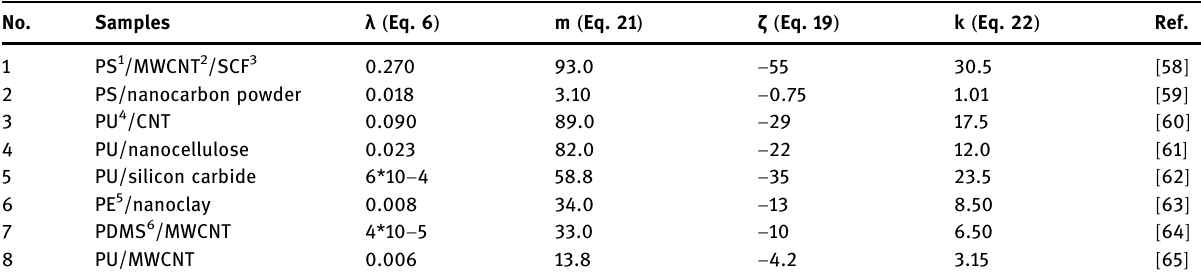
Table 2: The calculated parameters for reported SMPNs